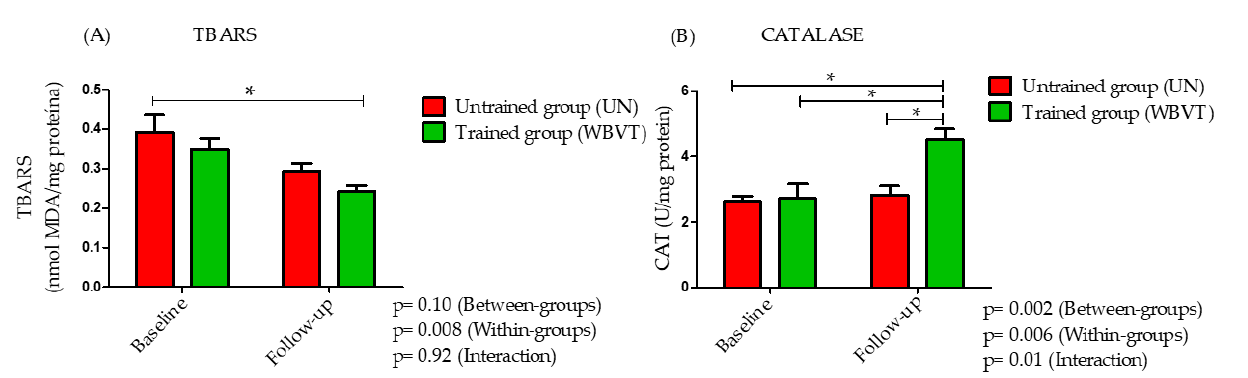
Figure 4. Effects of 6 weeks of whole-body vibration training (WBVT) stimulus on blood oxidative stress biomarkers and irisin levels. Plasma levels of thiobarbituric acid (TBARS) ( A ), catalase (CAT) ( B ), irisin ( C ), and visceral adipose tissue (VAT) ( D ) in control group (UN; n = 20) and training group (WBVT; n = 20). Values are presented as means and standard deviation. * Difference between groups ( p < 0.05). 4. Discussion The current study looked into how 6 weeks of WBVT affected oxidative stress mark- ers, irisin levels, and body composition in FM women. The major results showed that WBVT (i) reduced VAT, (ii) increased blood irisin levels, and (iii) reduced blood levels of TBARS. To our knowledge, this study is the first to investigate the effect of WBVT on oxidative stress markers and irisin blood levels in women with FM. Physical inactivity is frequently linked to an increase in FM symptoms, which exac- erbates the disease’s effects and makes it more difficult for patients to perform daily tasks, leading to obesity and further reductions in physical capability and quality of life [38]. Women with FM frequently have obesity [39,40]. The prevalence of obesity in women with FM was 78% in the current study, and the mean BMI was 30.86 kg/m 2 . The prevalence of obesity and overweight in FM patients has also been noted in other studies, and these conditions are linked to the disease’s severity, increasing symptoms such increased pain, fatigue, poor sleep, and a higher incidence of mood disorders [41,42]. Consequently, weight loss is a useful strategy for reducing symptoms. Studies have shown that non- pharmacological treatments such as physical activity and nutrition are effective treatment options for FM [43–50]. They also show that weight management, modified diets with a high antioxidant content, nutritional supplementation, and physical activity are all help- ful in reducing symptoms. Studies have found a cross talk between body fat, lean mass, and neuroinflammation [51]. Obesity and dynapenia are often harmful to skeletal muscle function and can lead to low-grade systemic inflammation, especially in chronic diseases such as FM [52]. In addi- tion to having a better ability to diminish visceral adipose tissue in obese middle-aged